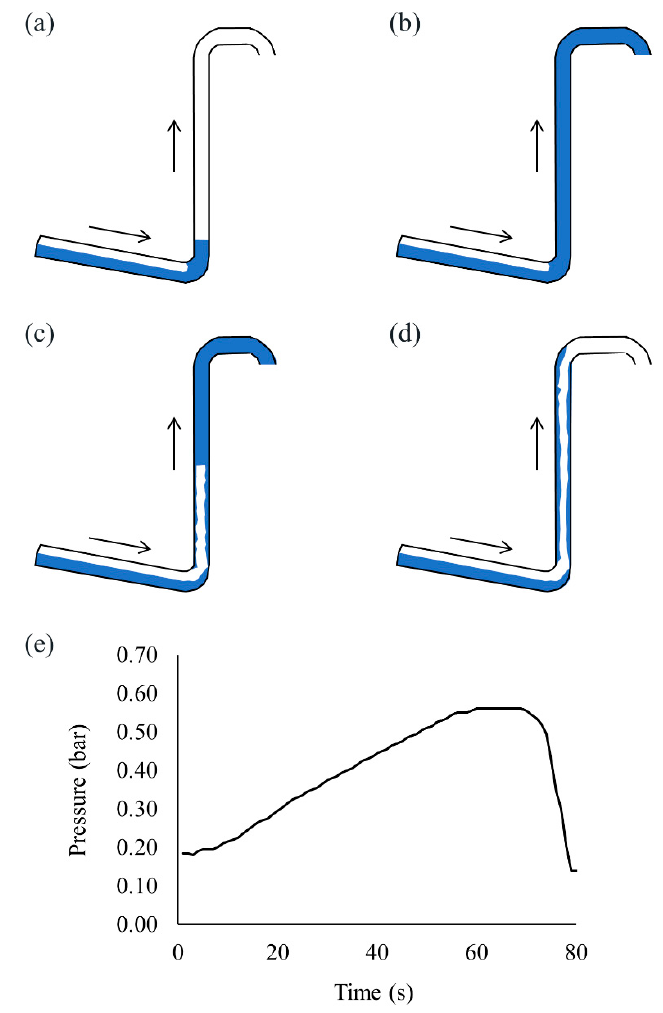
Figure 1. Process of severe slugging. ( a ) Slug formation; ( b ) slug movement into the separator; ( c ) blowout; ( d ) liquid fallback and ( e ) pressure at the riser base during one cycle of severe